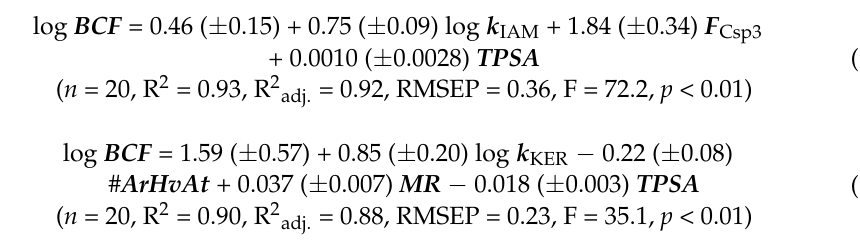
Table 4. Correlations ® between chromatographic and calculated parameters ( n = 32) .